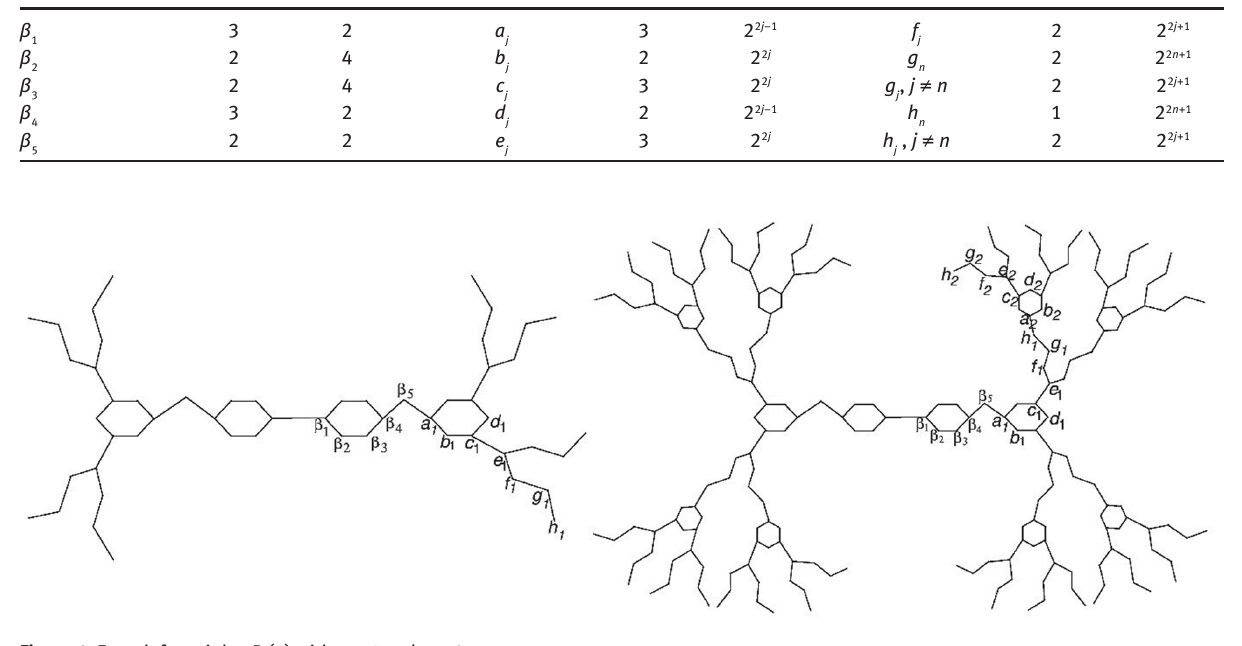
( n ) with n = 1 and n = 2. 1